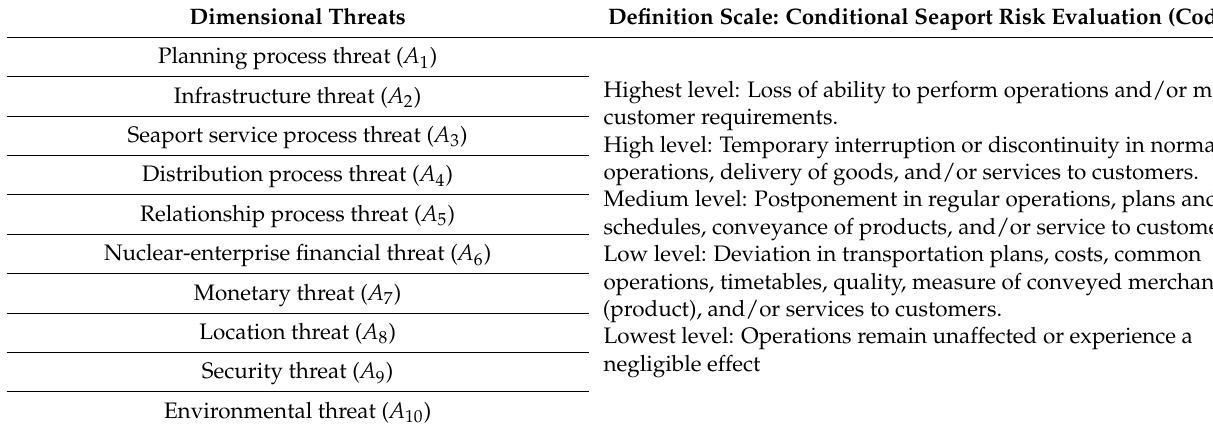
Table 2. Indices of seaport risk